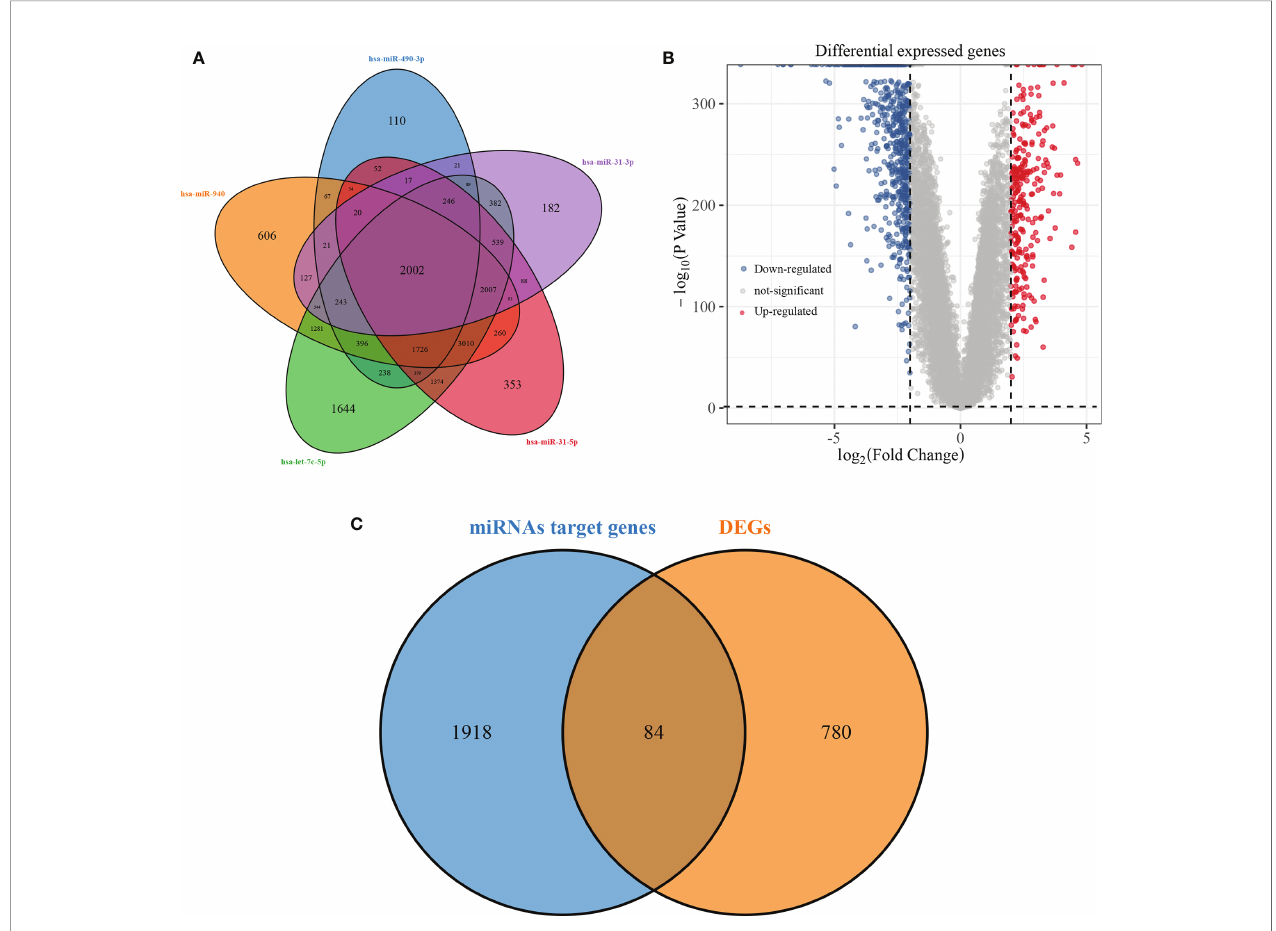
FIGURE 3 | Screening of miRNAs target genes and differentially expressed genes. ( A : overlapping Venn diagram of predicted target genes for 5 miRNAs; B : volcano diagram of differentially expressed genes in LUAD; C : overlapping Venn diagram of predicted target genes and differentially expressed genes for